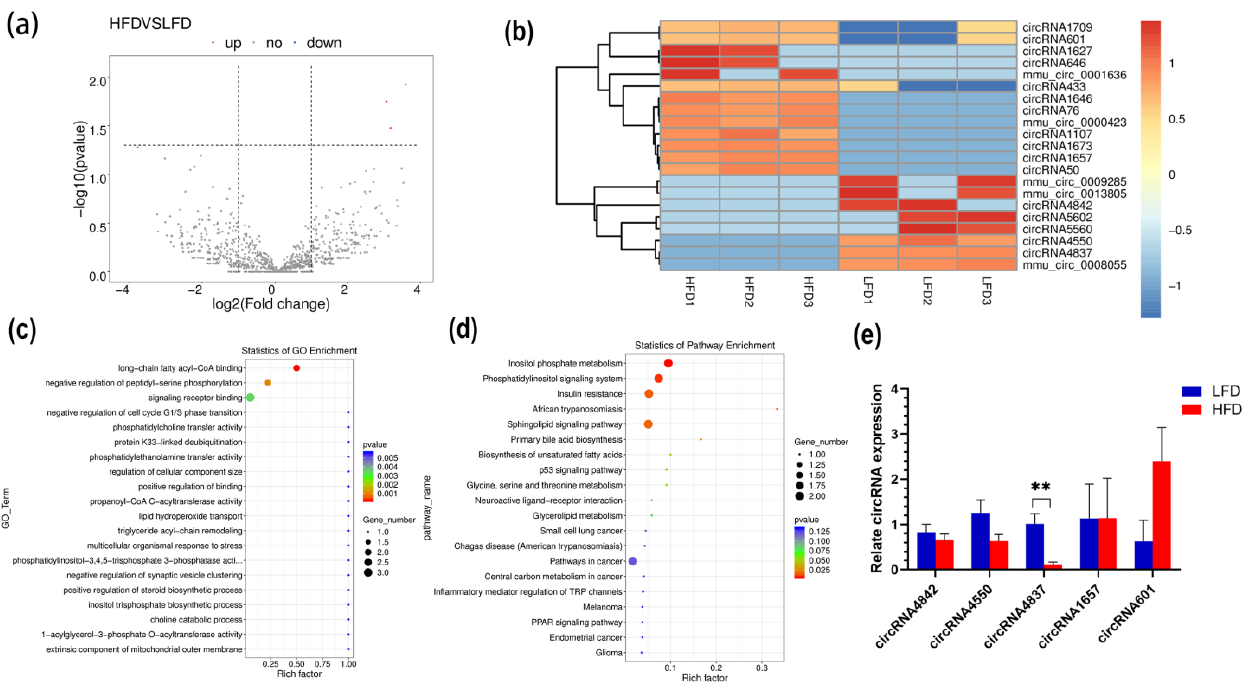
Figure 3. The analysis of DE circRNAs. ( a ) Volcano plot. Red represents upregulated and blue represents downregulated circRNAs. ( b ) heatmap of 21 DE circRNAs using DESeq2 rlog; ( c ) top 20 GO terms for parental genes with DE circRNAs; ( d ) top 20 KEGG pathways; ( e ) validation of five DE circRNA expression levels by RT-qPCR, ** p < 0.01.